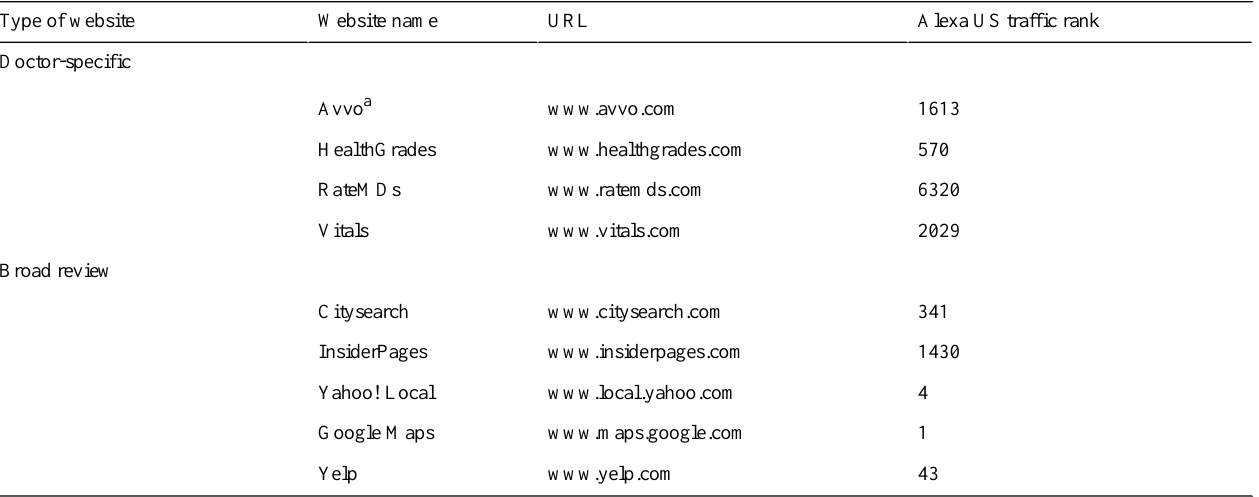
Table 4. Alexa traffic rank in the United States for selected review websites